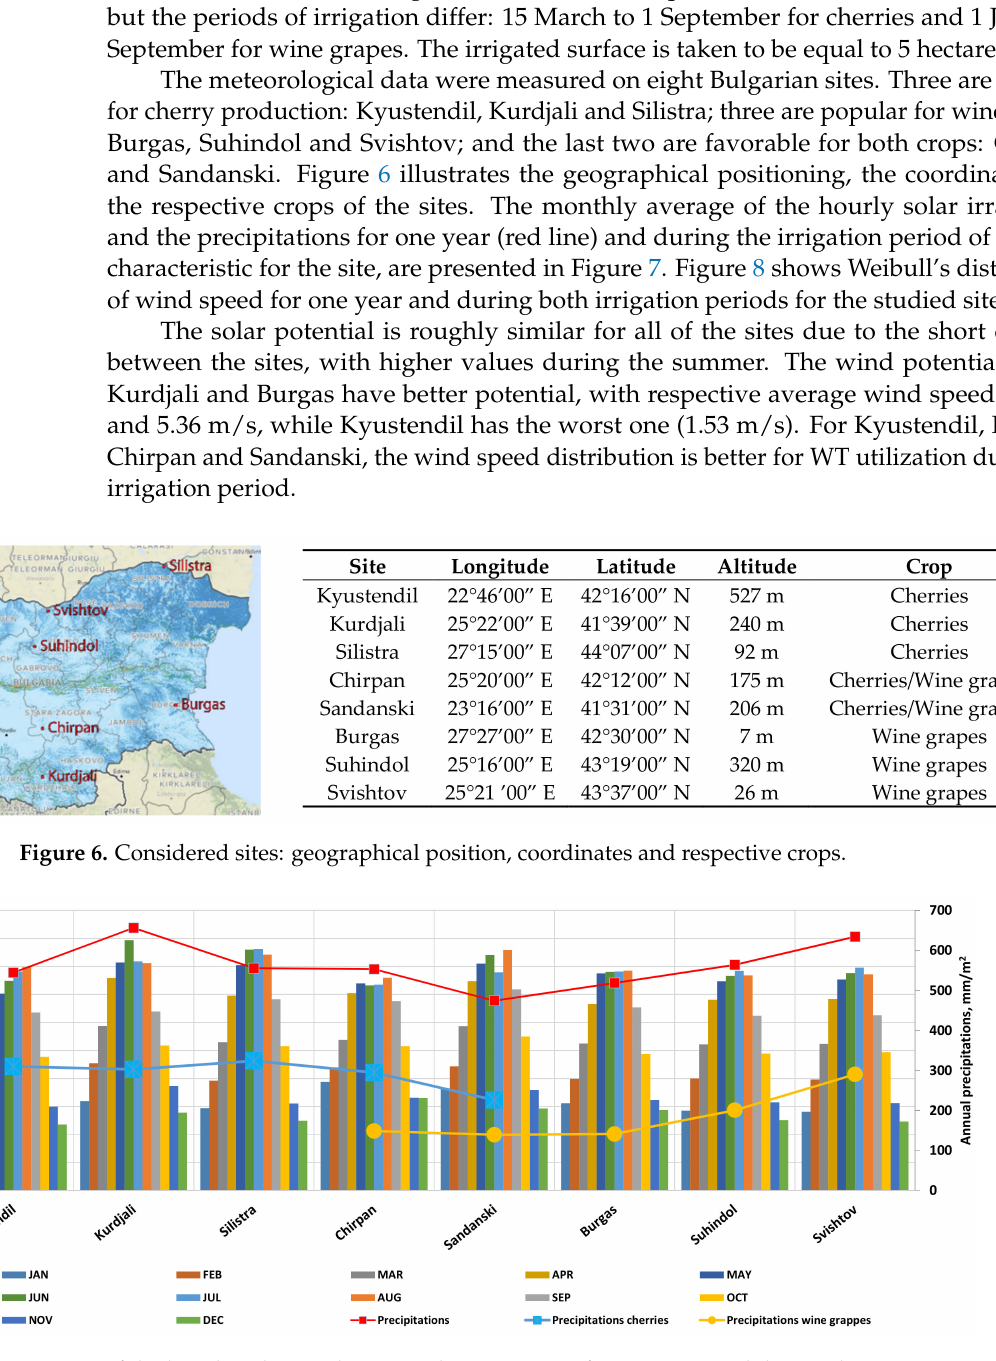
Figure 7. Monthly average of the hourly solar irradiation and precipitation for one year, and during the irrigation period for each